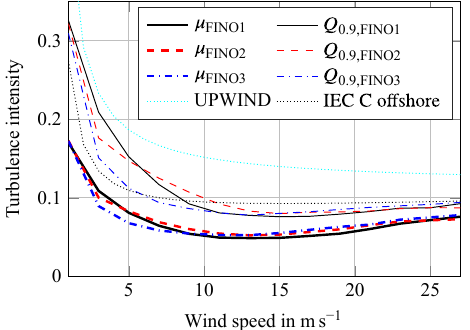
Figure 6. Probability distribution of the wave peak period for v s = 11–13ms − 1 for the FINO3 site.